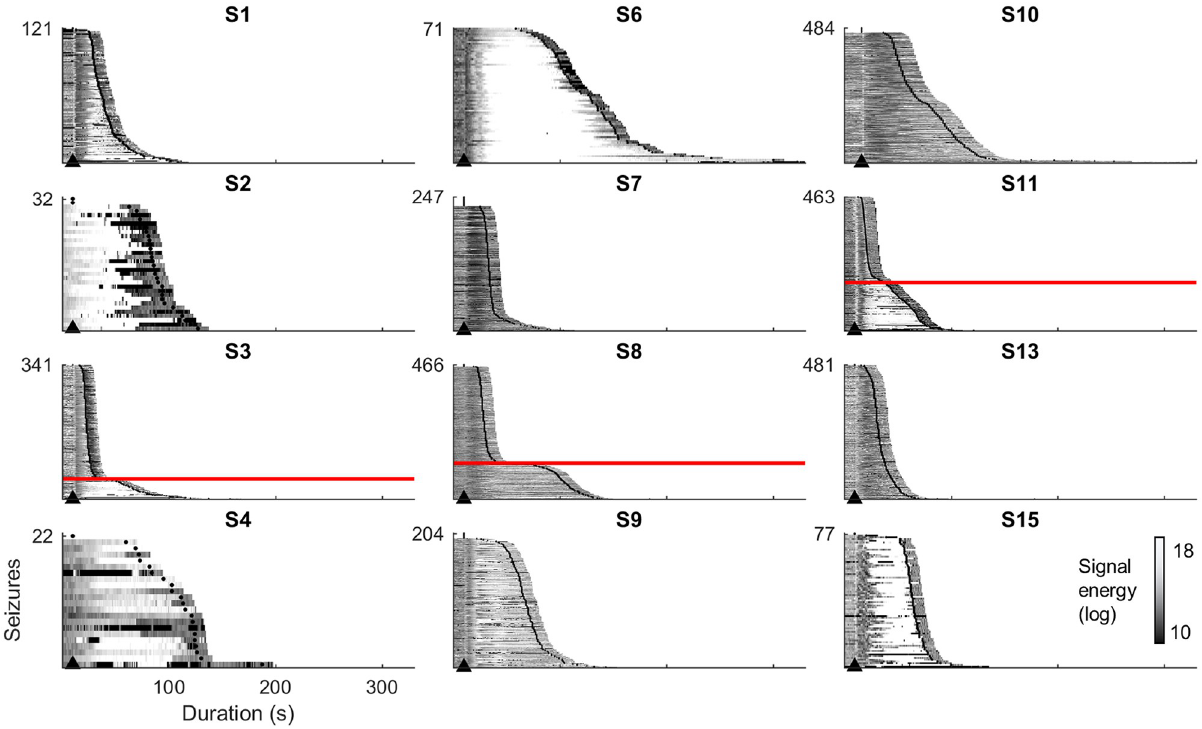
Fig 2. Seizure energy. Average signal energy during evolution of seizures, sorted by duration, from 10s before seizure onset (marked by arrowhead) to 10s after seizure termination (according to clinicians’ marking). Red lines mark the divisions between long and short populations of seizures within bimodal subjects. Energy for individual electrode channels is provided in the supplementary